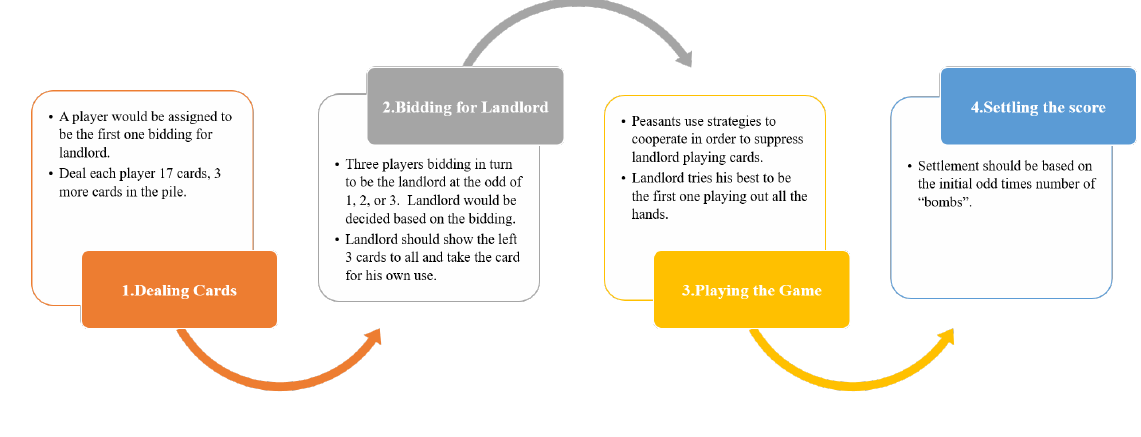
Figure 3. Stages of classical